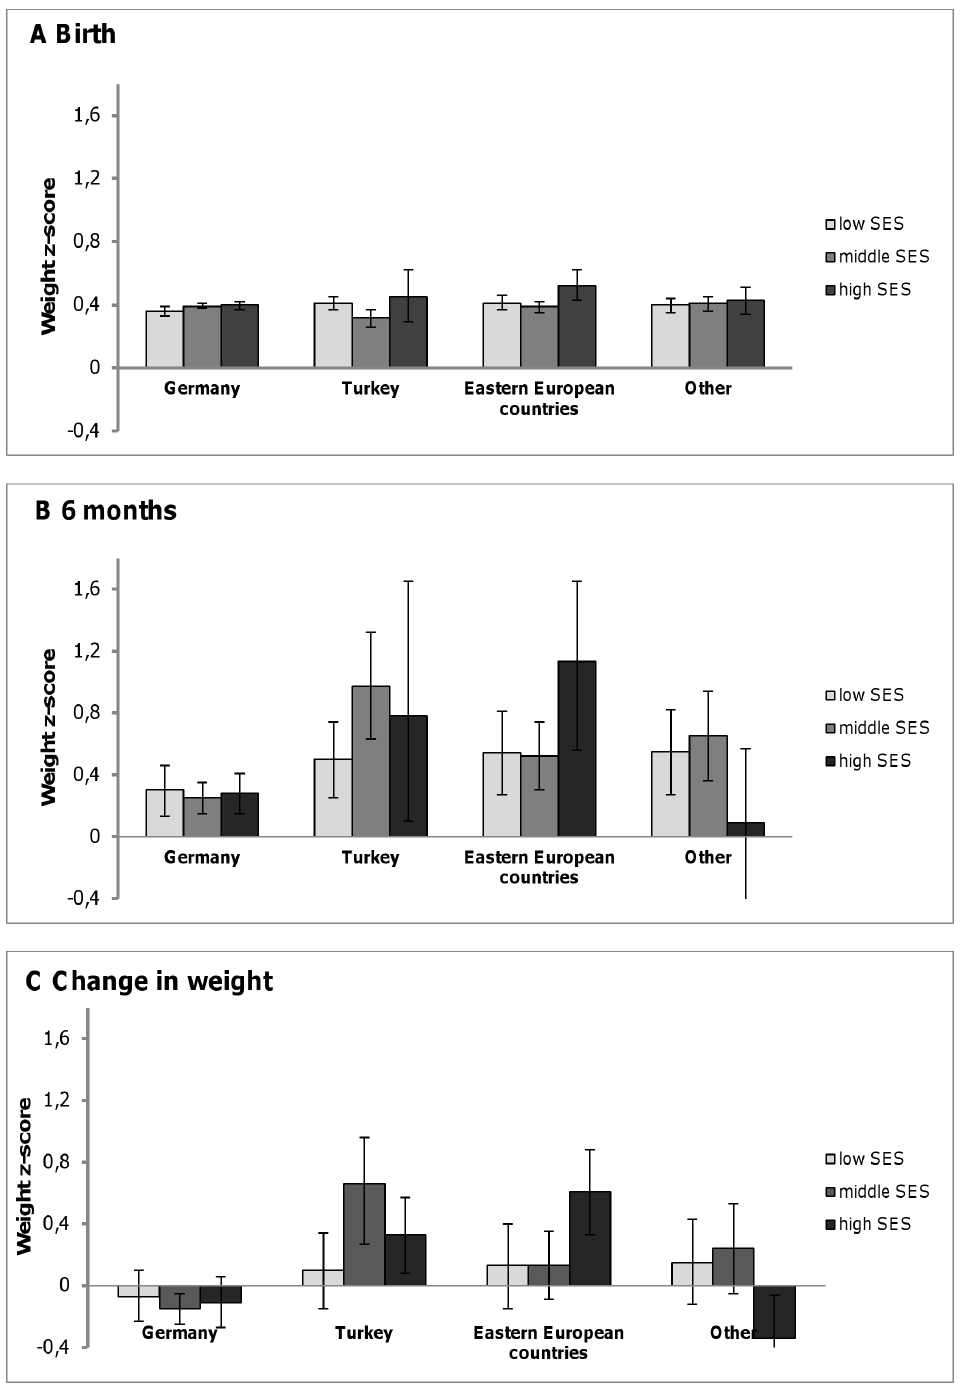
Figure 2. Adjusted mean weight z-scores and 95% CIs according to migrant background and SES. (mean weight z-score adjusted for birth weight, gestational age, parental height, smoking during pregnancy, duration of exclusive breastfeeding).